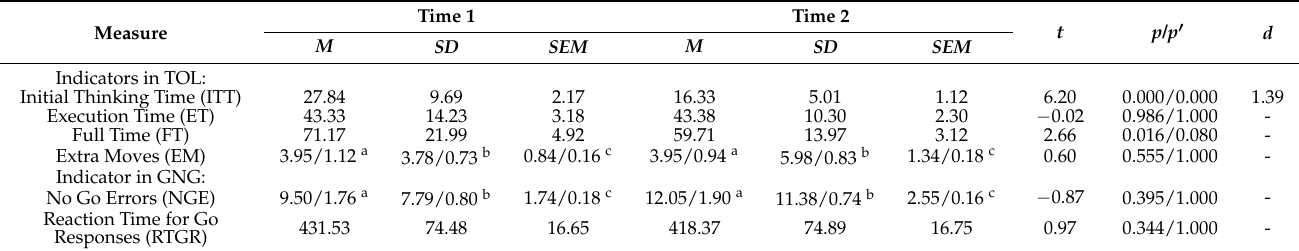
a Mean after Box-Cox transformation. b Standard deviation after Box-Cox transformation. c Standard error of measurement after Box-Cox